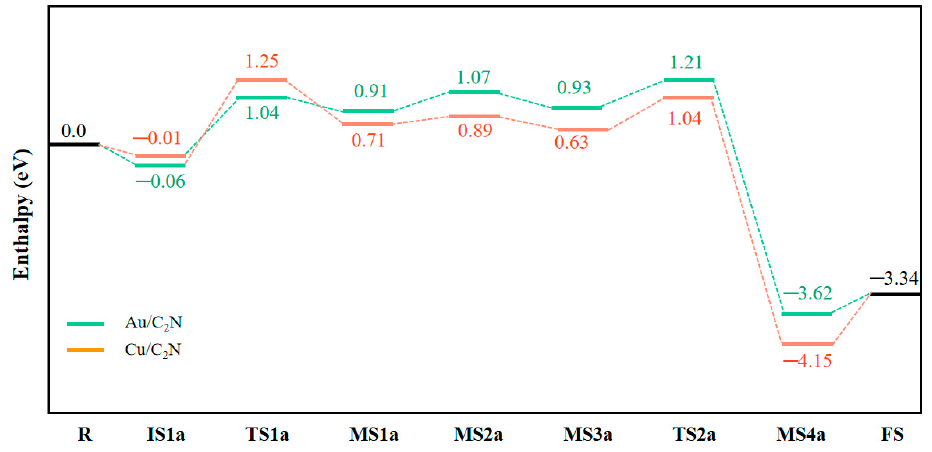
Figure 3. The energy profiles along the MEP for N 2 O reduction via mechanism I. (R: M/C 2 N + N 2 O + CO, FS: M/C 2 N + N 2 + CO 2 .) . Table 1. Relative energy ( Δ E corr ), enthalpy ( Δ H corr ) and free energy ( Δ G corr ) with zero-point vibra- tional correction for all the species in the both reactions. (unit: eV) .